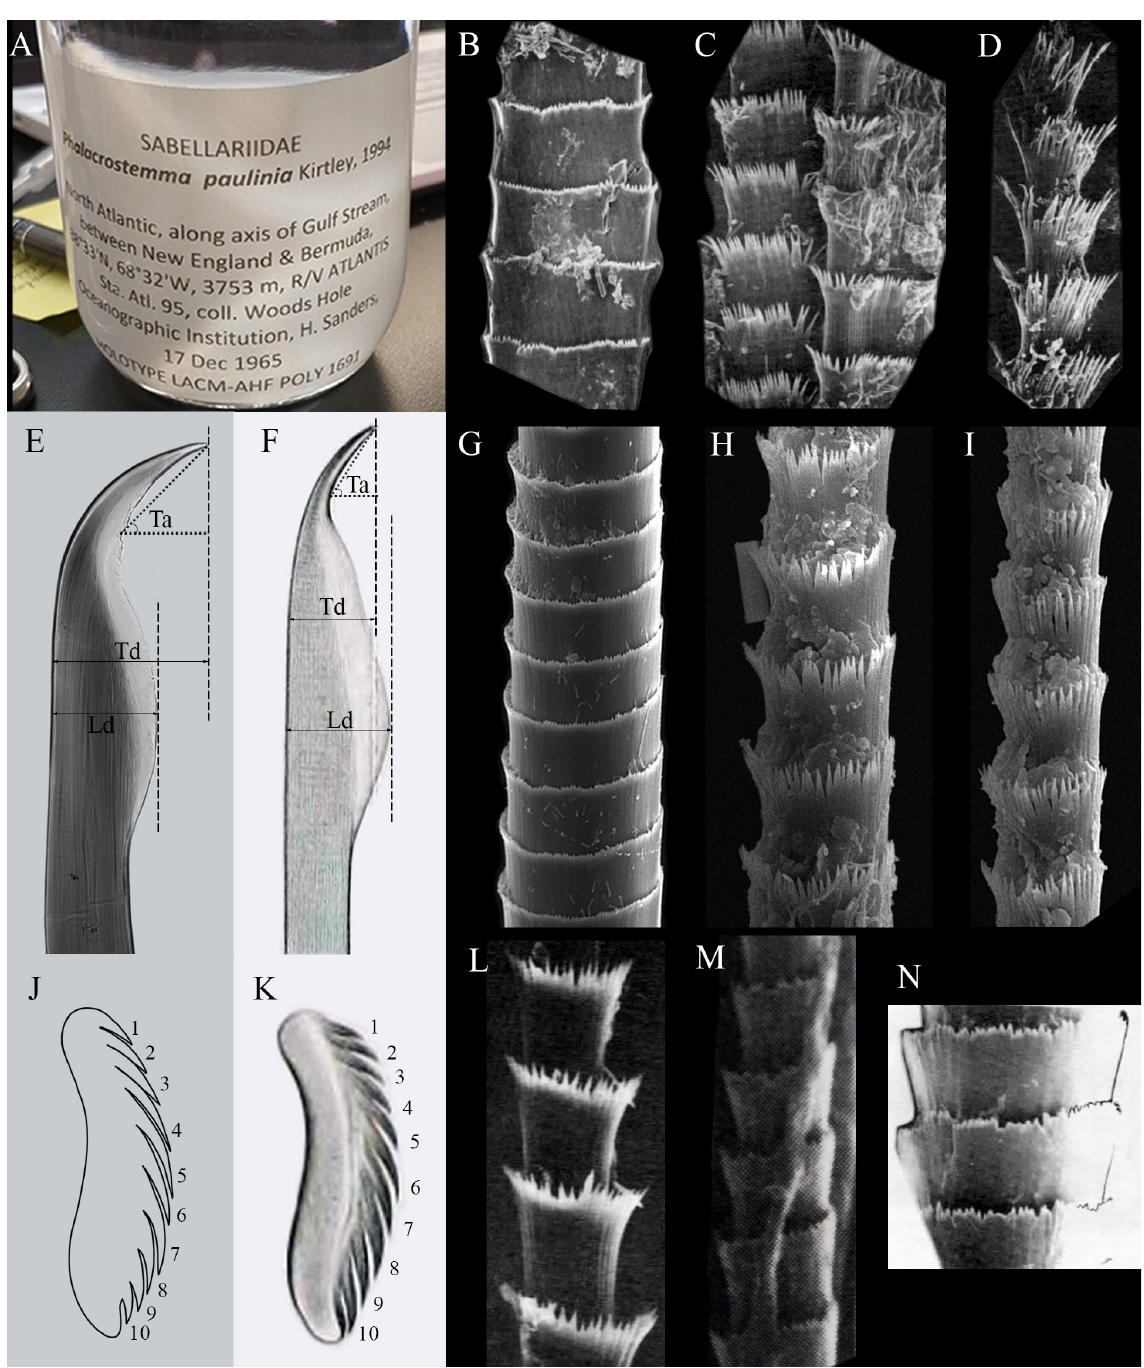
Fig. 8. Comparation between some species of Phalacrostemma Marenzeller, 1895. A . Holotype vial of P. paulinae Kirtley, 1994. B–D . Outer palea of P. paulinae . B . Proximal region. C . Middle region. D . Mid- distal region. E . Nuchal hook of P. danieli sp. nov. F . Nuchal hook of P. tenera (Augener, 1918). G–I . Outer palea of P. danieli sp. nov. G . Proximal region. H . Middle region. I . Mid-distal region. J . Abdominal uncini of P. danieli sp. nov. K . Abdominal uncini of P. tenera . L . Middle region of outer palea of P. gwendolynae Kirtley, 1994. M–N . Middle region of outer palea of P. gloriaae Kirtley, 1994. Abbreviations: Ld = limbo distance; Ta = tip angle; Td = tip distance. Numbers indicate the rows of teeth. A, Photo taken by Sergio Salazar-Vallejo; B–D, L–N, modified from Kirtley (1994); F, K, from Augener